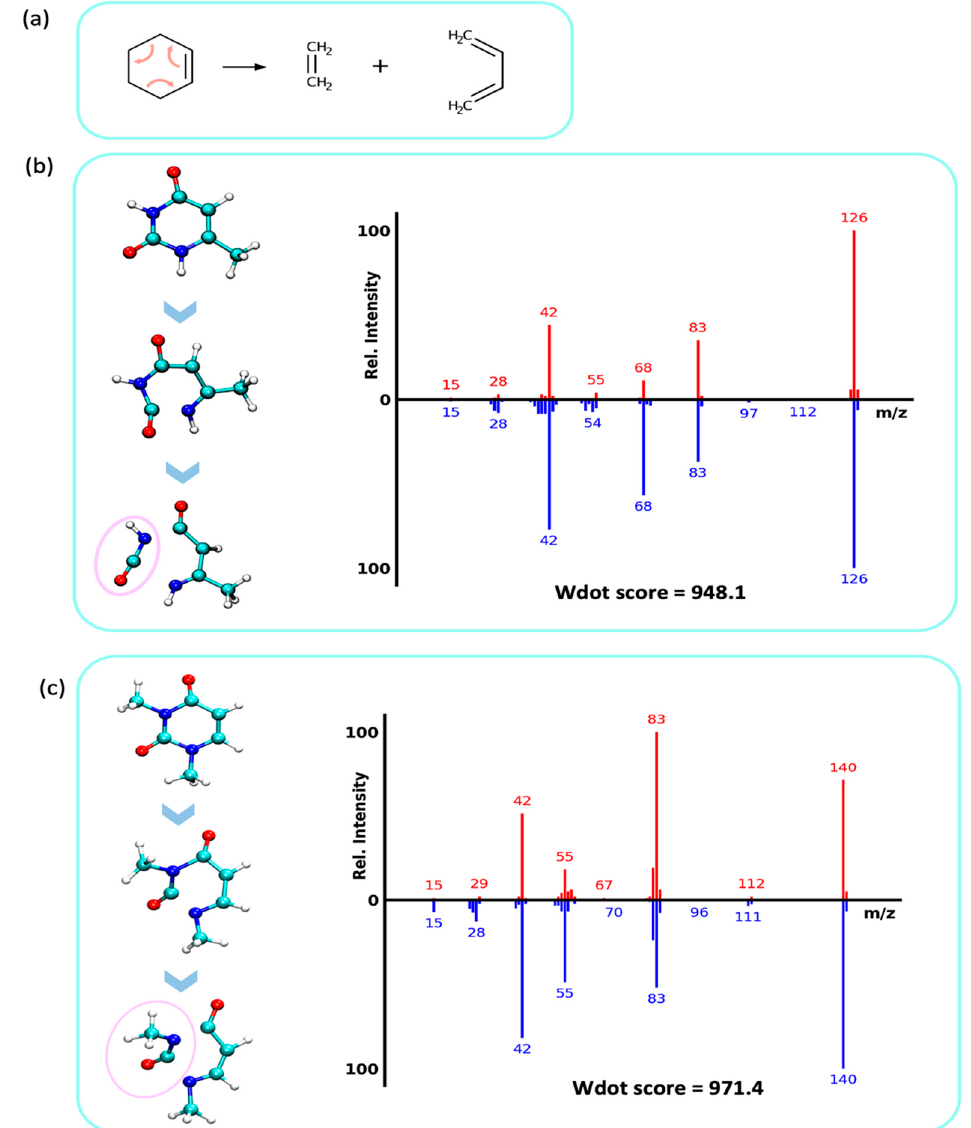
Figure 6. Retro Diels–Alder reactions in electron ionization fragmentation. Top: QCEIMS, bottom: experimental spectra. ( a ) Mechanistic example of a retro Diels–Alder fragmentation. ( b ) Analysis of QCEIMS trajectories for 6-methyluracil marking the neutral loss of isocyanic acid (43 u, pink circle, yielding m/z 83). ( c ) Analysis of QCEIMS trajectories for 1,3-dimethyluracil marking the neutral loss of methyl-isocyanic acid (57 u, pink circle, yielding m/z 83).